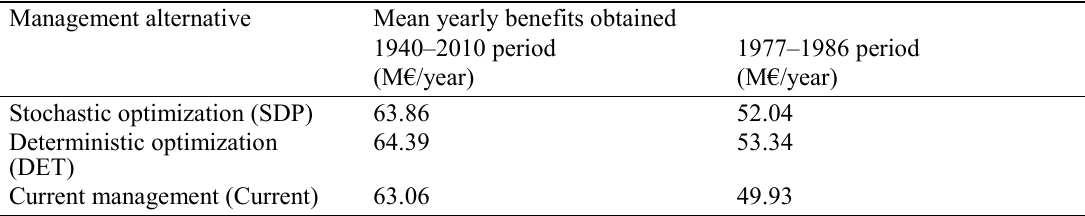
Fig. 2 Comparison between yearly benefits obtained with stochastic and deterministic optimization and simulation. Table 1 Comparison between mean benefits obtained with stochastic and deterministic optimization and